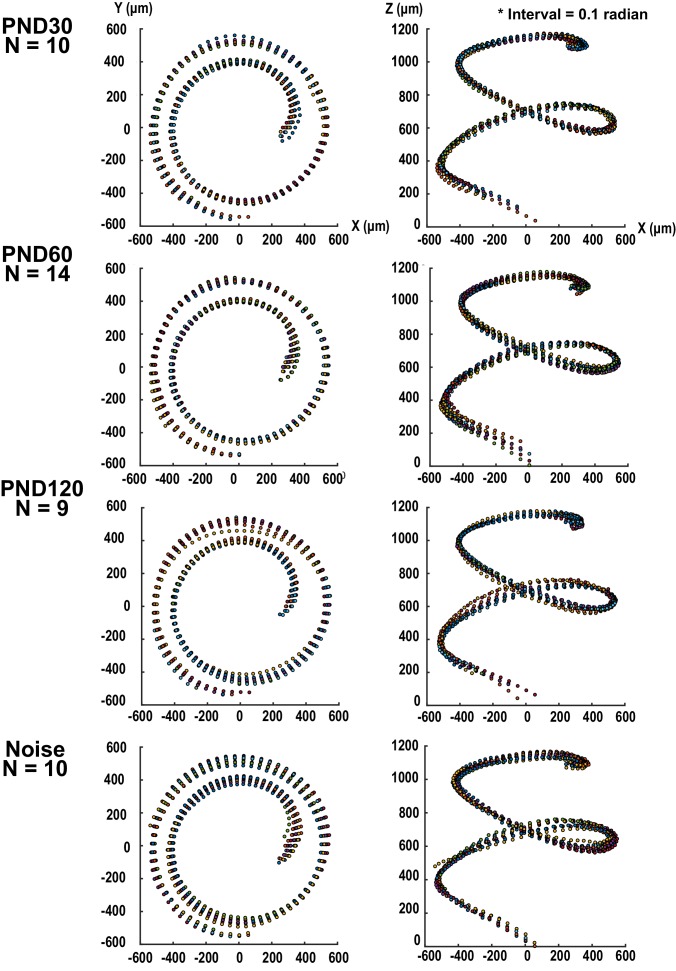
Three-dimensional presentation of hair cell distribution projected to X-Y and Y-Z planes.Positions of Inner hair cells were sampled with regular intervals and the position data from different samples were overlaid. Hair cells from different samples were plotted as dots with different colors. Spiral directions of samples from right ears were converted to those of left ears for alignment of samples from both sides. PND, postnatal day.